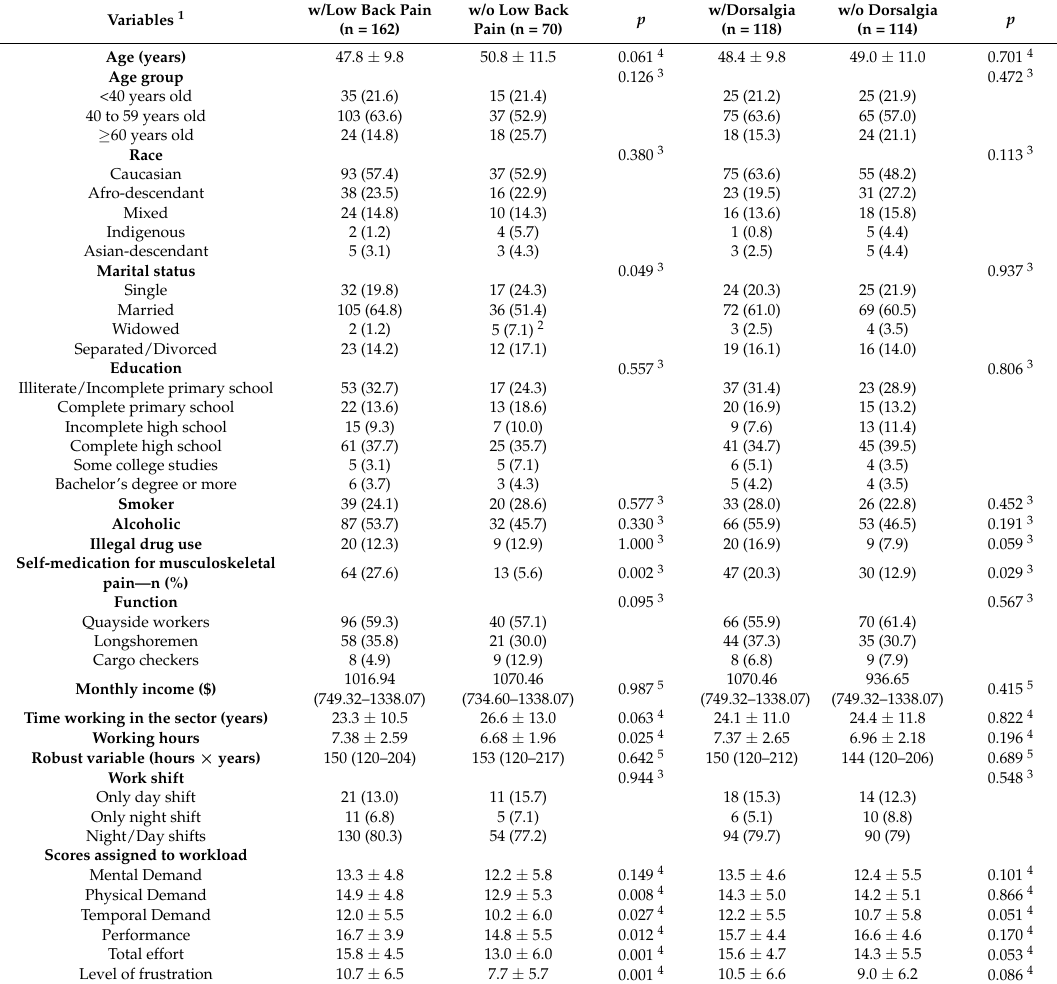
Table 3. Association of variables with dorsalgia and low back